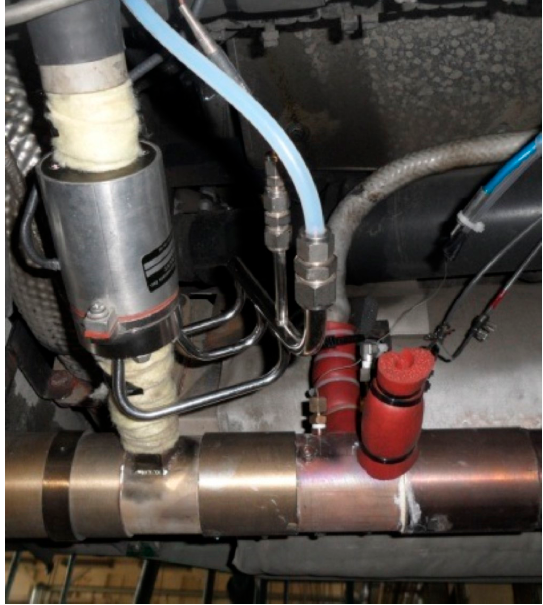
Figure 2. Installation of the volumetric flow meter and PM 10 probe on the exhaust system of the CNGE5